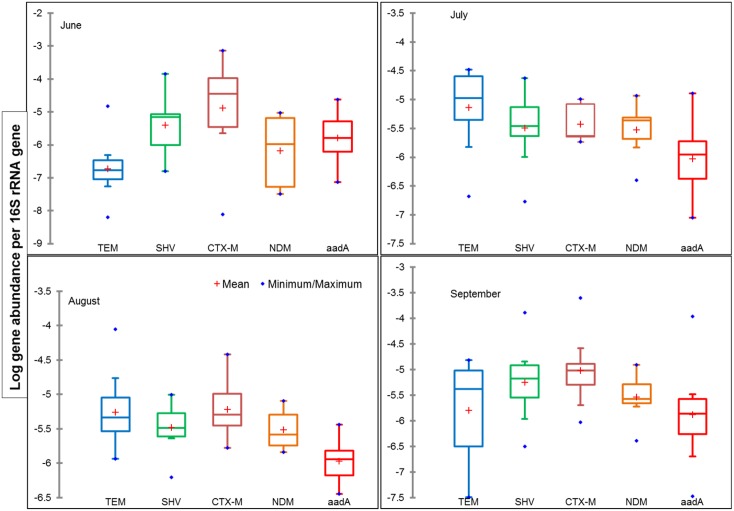
Gene copy numbers of antibiotic resistance genes (blaTEM, blaCTX‑M, blaSHV, blaNDM and aadA,) normalized to 16S rRNA gene copy numbers in sediment samples collected for 4 months (June to September) at selected HOP.The box plot represents the first and third quartile, the blue dots on maximum/minimum values and the red cross indicate mean.